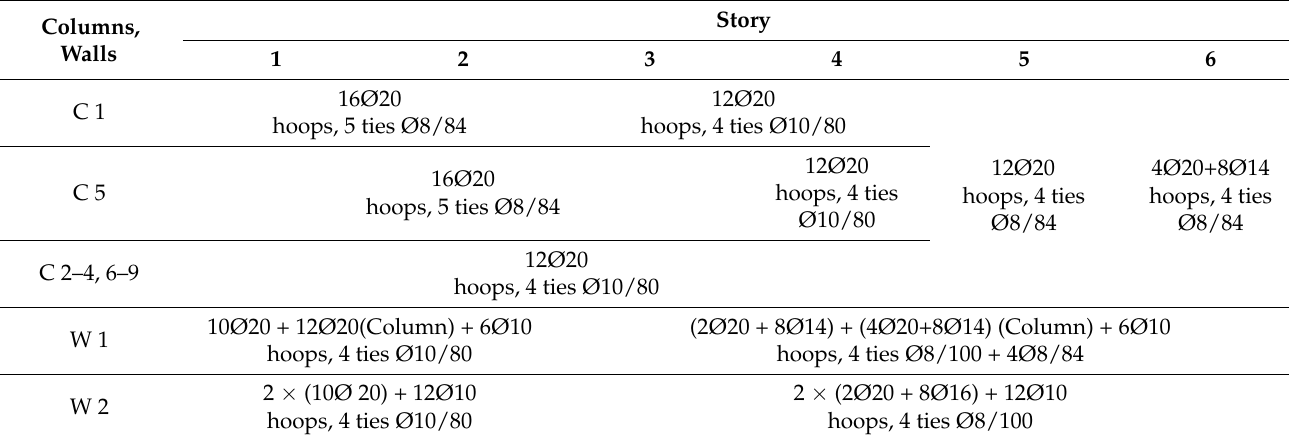
Table A2. Longitudinal and transverse confinement reinforcement (hoops) details of columns/walls of the six-story building.